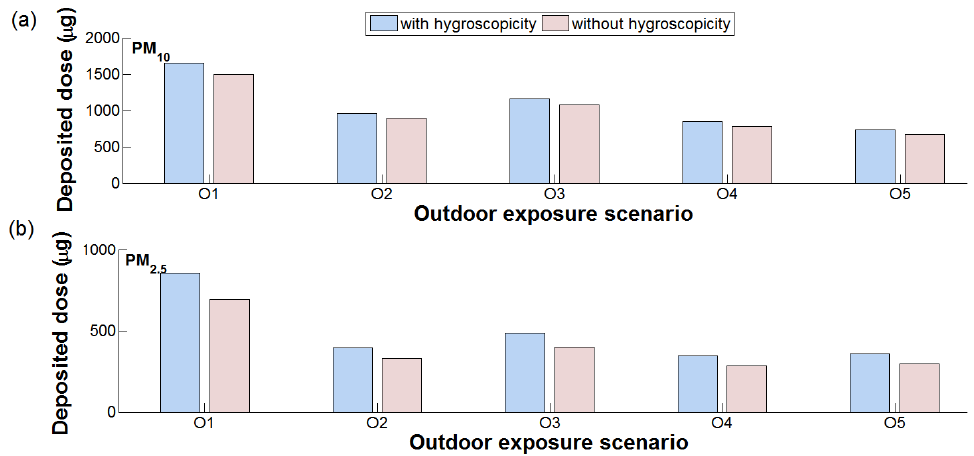
Figure 6. Weekly (5 days) deposited dose of ( a ) PM 10 and ( b ) PM 2.5 in the respiratory tract of children at the fixing monitoring station with and without the hygroscopic effect.